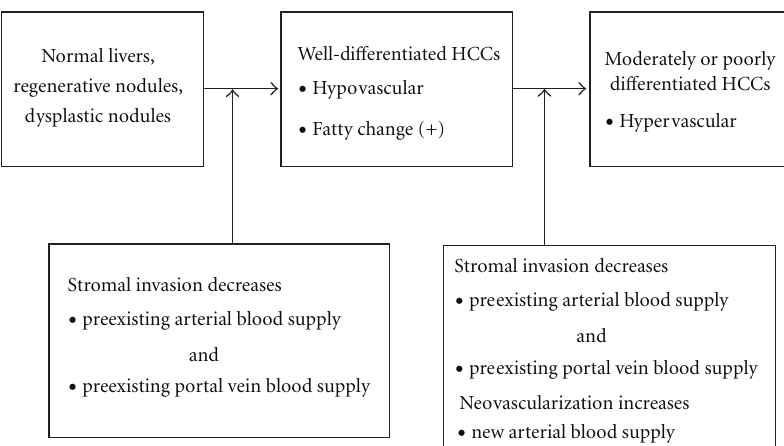
Figure 3: Relationship between cancer development, vascularity, histological feature (fatty change), and stromal